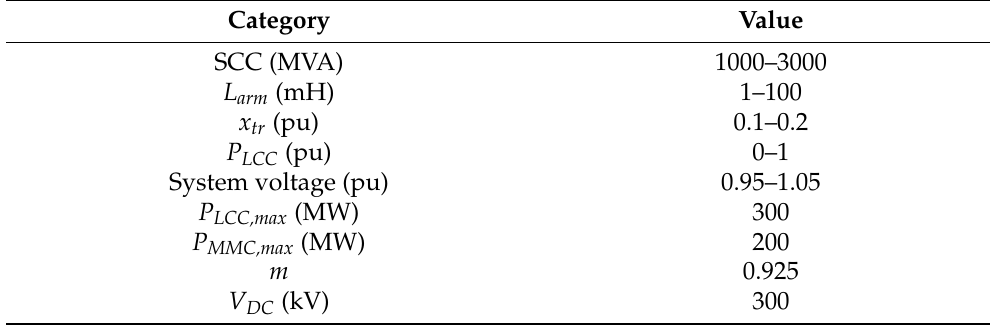
Table 3. Possible combinations of parameters for Jeju HVDC No. 3 to determine the full operating region.